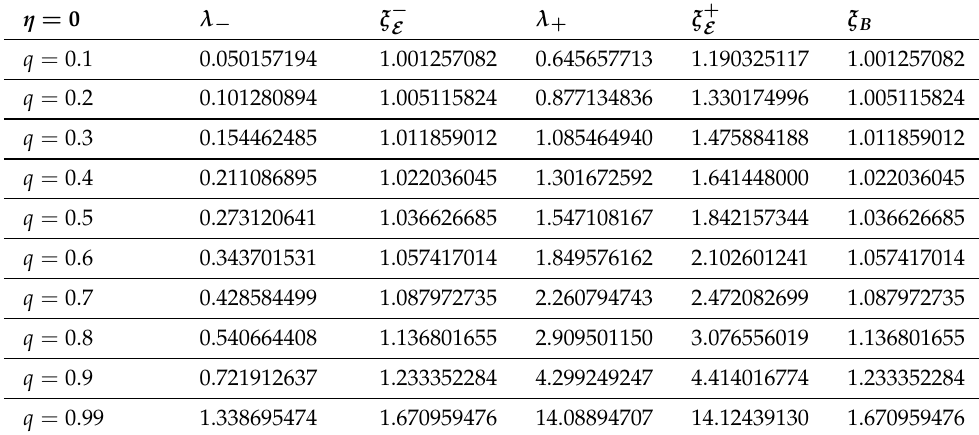
Table 1. Typical values of the zeroes λ ± of the polynomial equation p − = 0 in (67) with the corresponding values ξ ± E for the inner and outer boundaries of the ergoregion on the equatorial plane η = 0. The last column represents the only positive real root of order two for the function B restricted to the equatorial